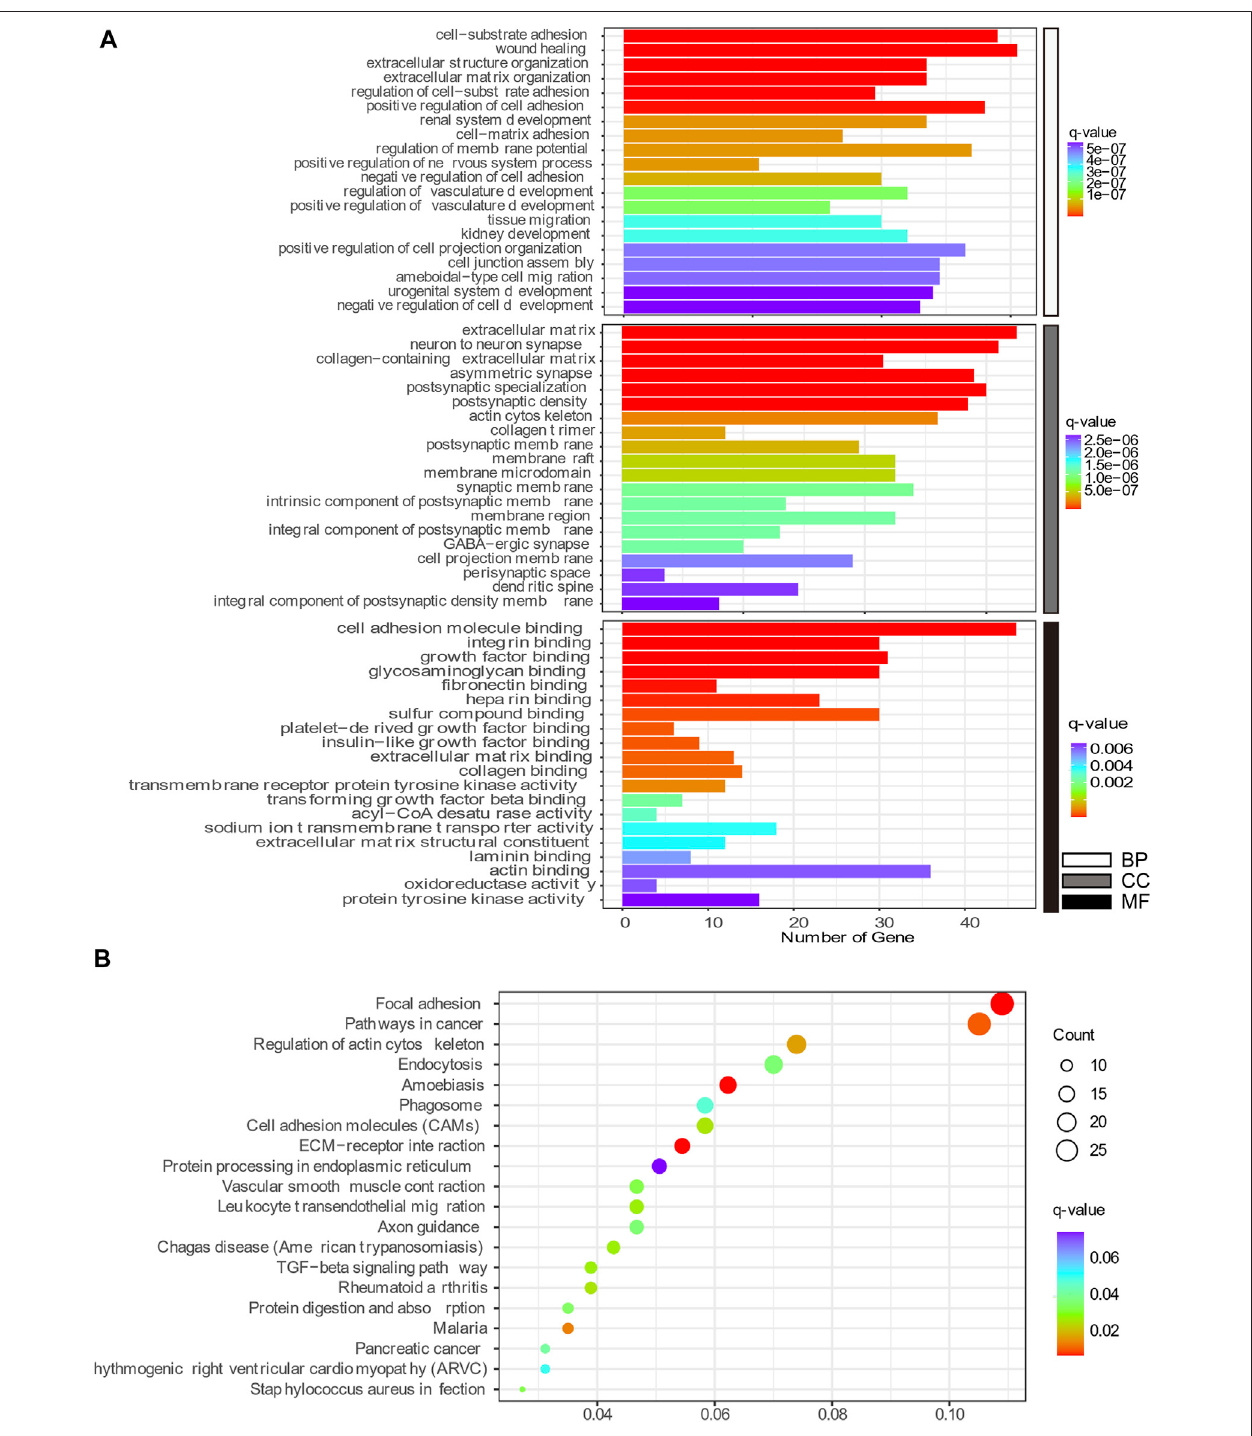
FIGURE 6 | Top 20 GO and KEGG pathway enrichment annotations. (A) Biological process (white), cellular component (gray), and molecular function (black). The horizontalaxisrepresentsthegenenumber,whichwasenrichedontheGOterm,andtheverticalaxisshowstheGOtermnamefromtheanalysisofcommonDEmRNAs shared by both the x12A and x90 groups identi fi ed at the gene level. The node color changed gradually from blue to red in ascending order according to the negative log10(q-value). (B) Top20KEGGpathway-enrichedanalyses.Thesizeofthespotindicatesthenumberofenrichedgenesinthepathway,andthecolorofthespot indicates the signi fi cance level of the enriched pathway. The horizontal axis shows the gene ratio of the GO term, and the vertical axis shows the KEGG term name.